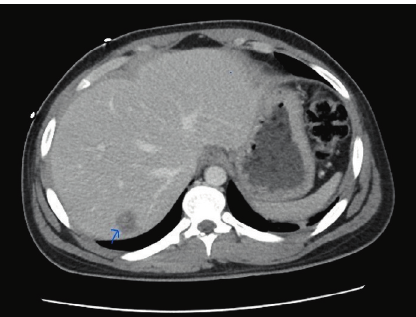
Figure 1: C.T. abdomen revealing abscess in the 7th segment of the liver.